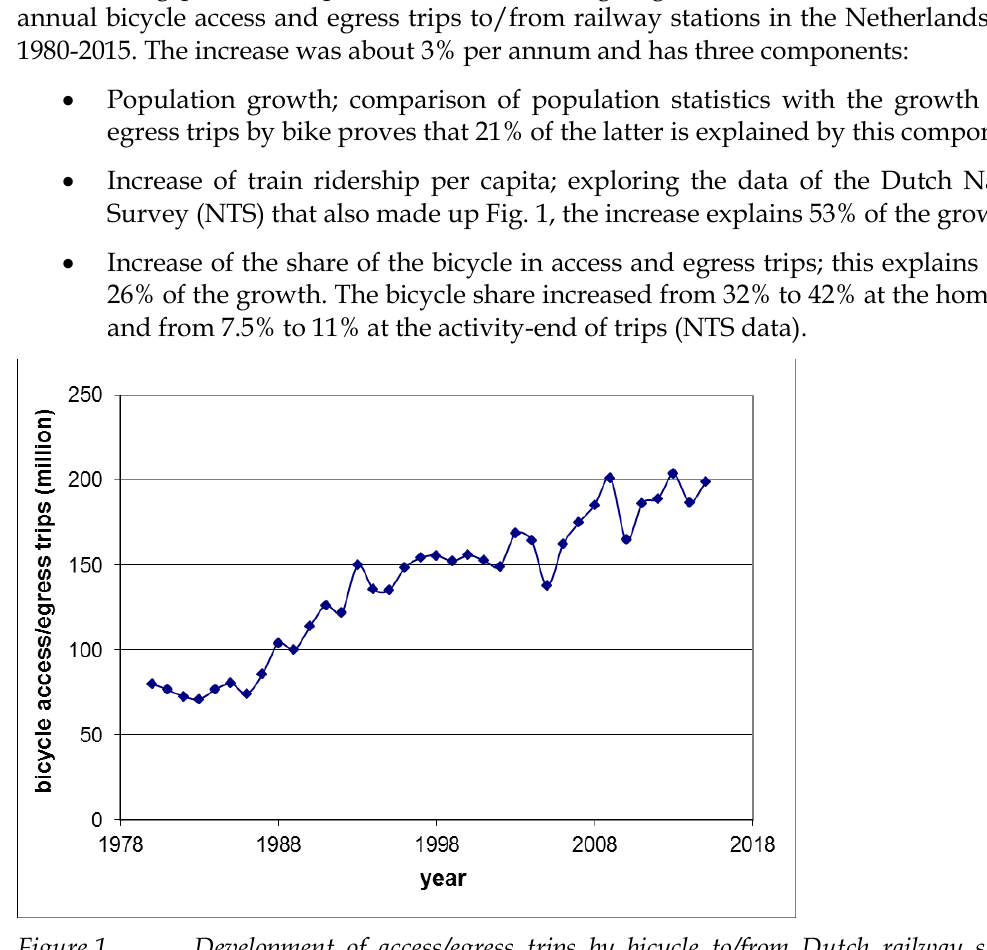
Figure 1. Development of access/egress trips by bicycle to/from Dutch railway stations; source: microdata of the Dutch